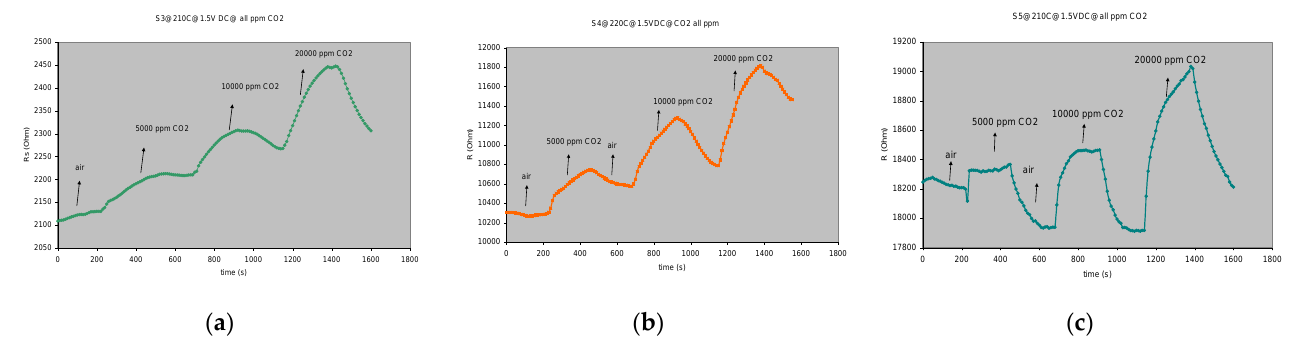
Figure 5. The response/recovery characteristics for 3 successive injections of CO 2 (5000–20,000 ppm) at corresponding T w : ( a ) S3 sensor, T w = 210 °C; ( b ) S4 sensor T w = 220 °C; ( c ) S5 sensor, T w = 210 °C.